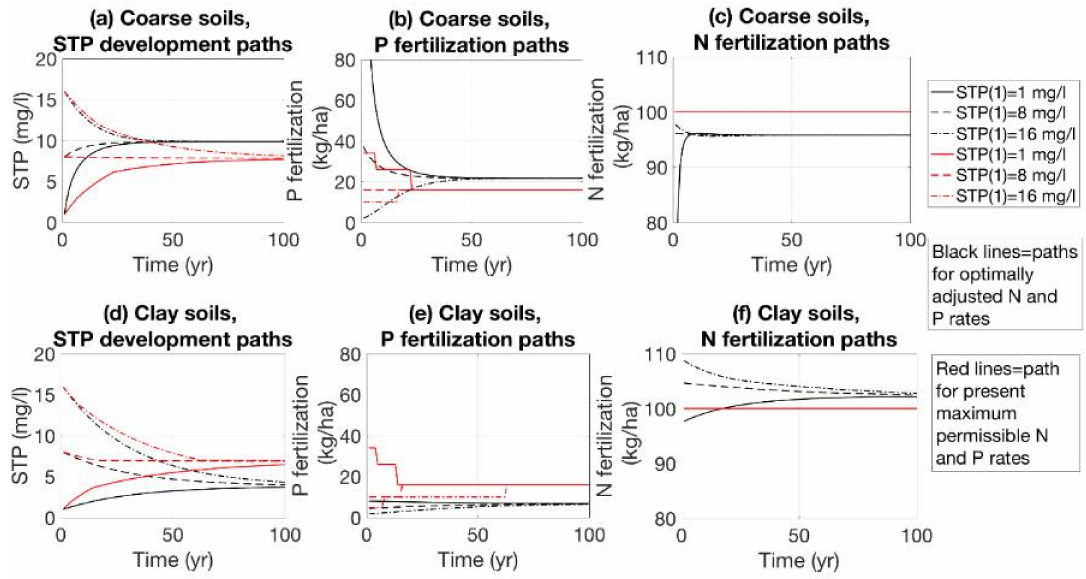
Figure 6. The effect the initial STP level on paths for STP development and for P and N fertilization for two fertilization management